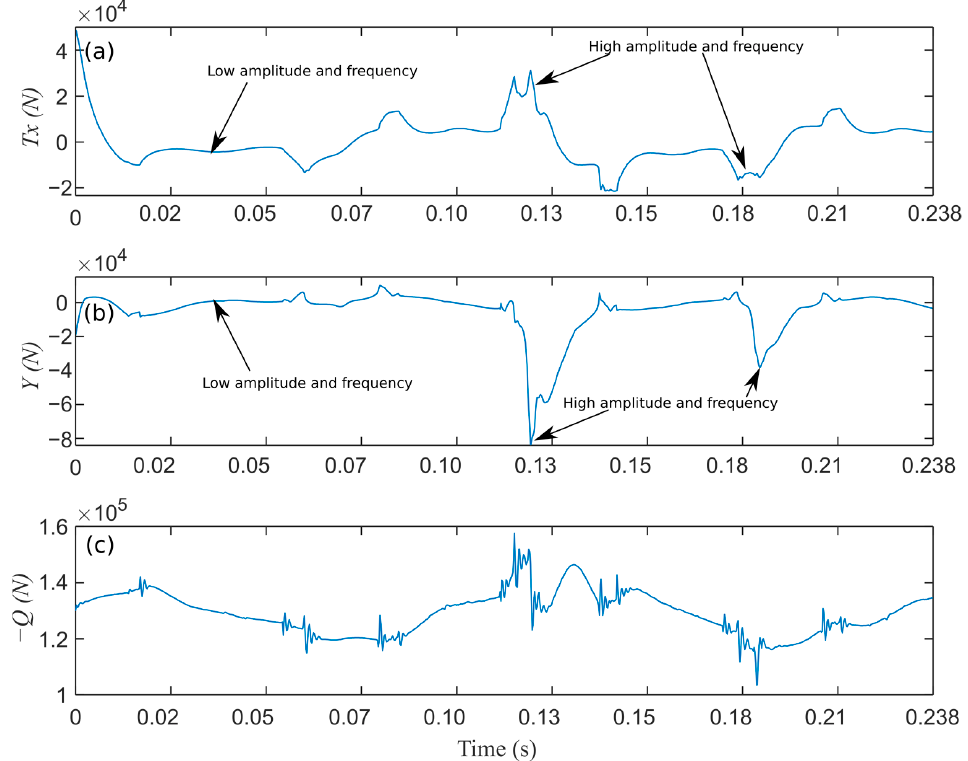
Figure 8. The computed input forces for the rail model by the Simpack software. ( a ) Longitudinal force T x , ( b ) Lateral force Y , ( c ) Vertical force Q